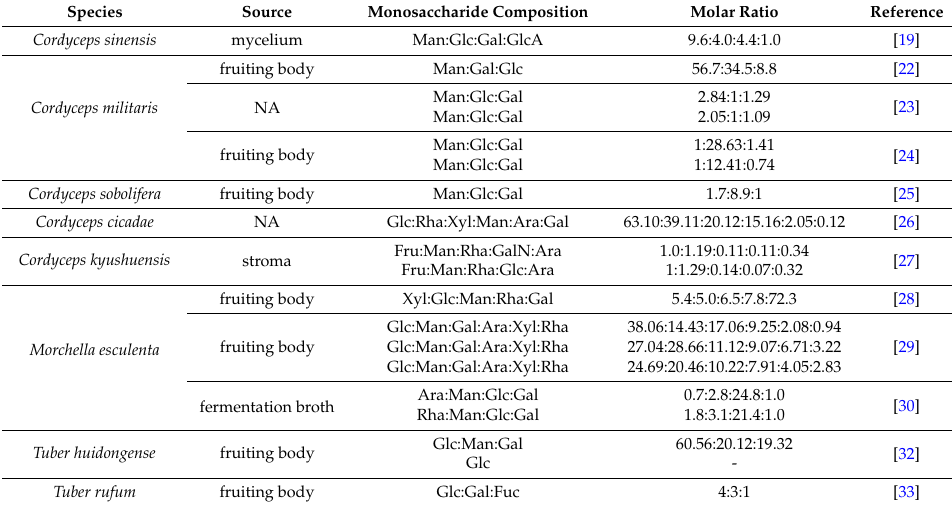
Tuber huidongense fruiting body Tuber rufum fruiting body